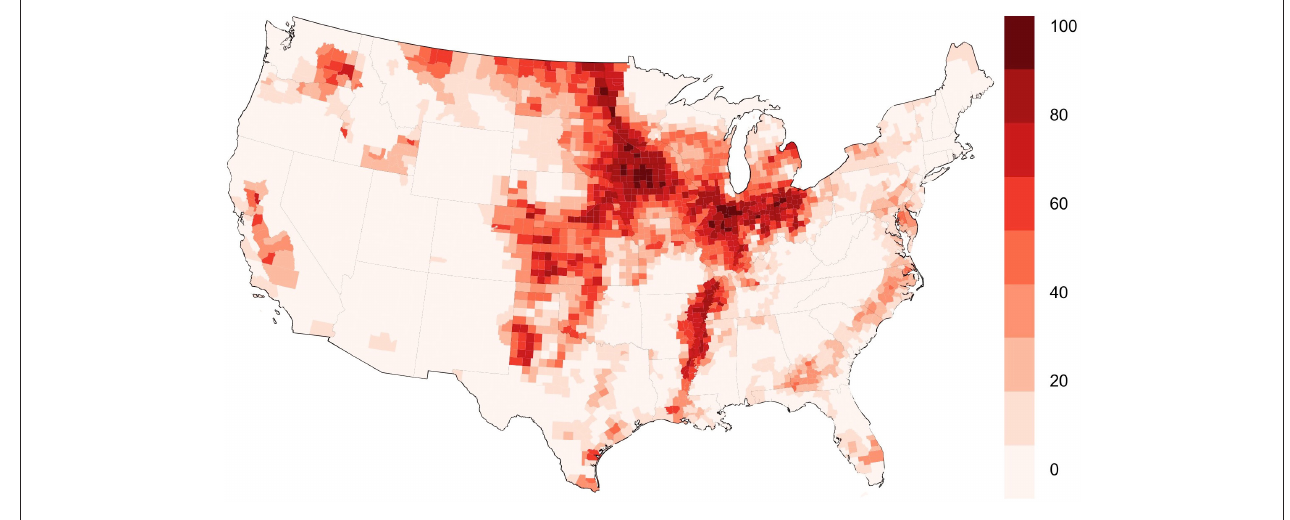
FIGURE 3 | Percent cropland by county in 2012. Data: NWALT.